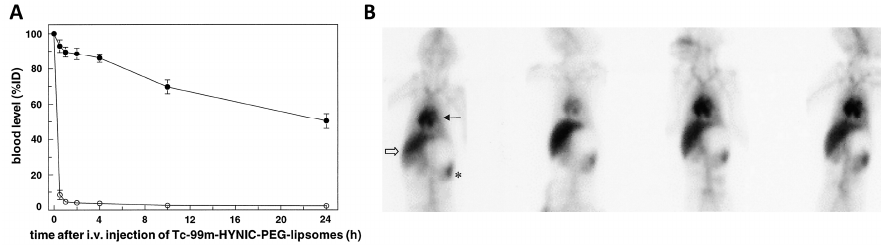
Figure 3. Accelerated blood clearance (ABC) of 99m Tc-labeled HYNIC-PEG liposomes. ( A ) Time course of the blood levels of 99m Tc-labeled N -hydroxysuccinimidyl hydrazino nicotinate hydrochloride (HYNIC)-PEG liposomes measured as the percentage of the injected dose at different times after two consecutive intravenous injections performed in rats with a one-week interval. Notice that whereas blood radioactivity declined slowly after the first injection (black circles), it decreased very rapidly after the second (white circles), hence showing the accelerated blood clearance phenomenon. Reproduced with slight modifications from [116] with permission from the publisher; ( B ) Whole body scintigraphic images obtained in a rhesus monkey after four consecutive intravenous injections of 99m Tc-labeled HYNIC-PEG liposomes performed on Day 0, Day 7, Day 21 and Day 35 of the study as indicated. Each image was obtained four hours after each intravenous injection of labeled liposomes. Notice that the spleen is strongly labeled at all time points and that signal intensity over the liver area strongly increases at the second injection performed seven days after the first one. → indicates the heart, ⇒ the liver, and ∗ the spleen region. Reproduced from [116] with permission from the